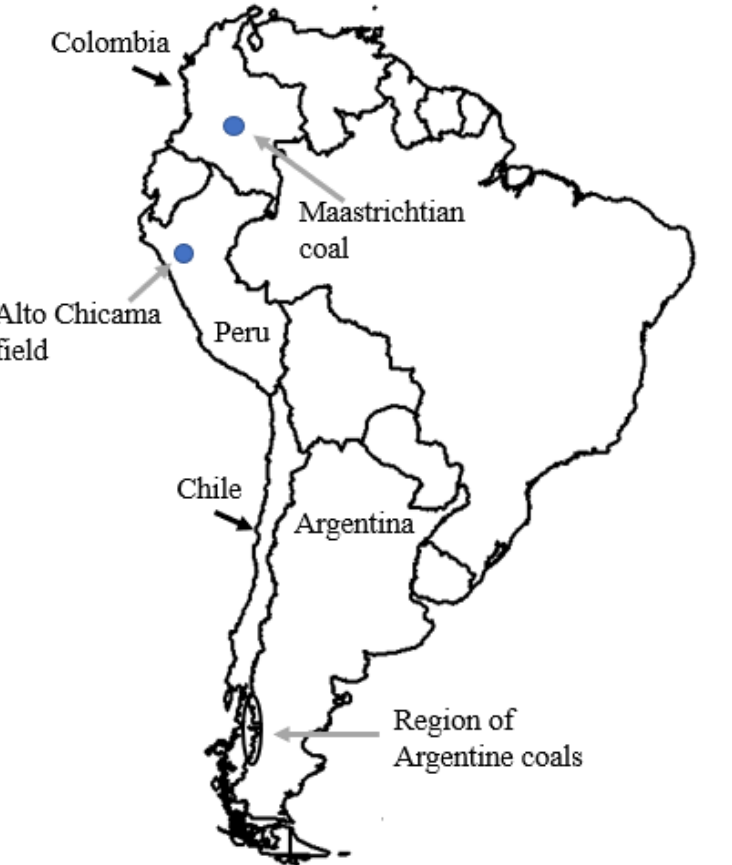
Figure 9. Map of South America with the approximate locations of the coalfields mentioned in the text shown.